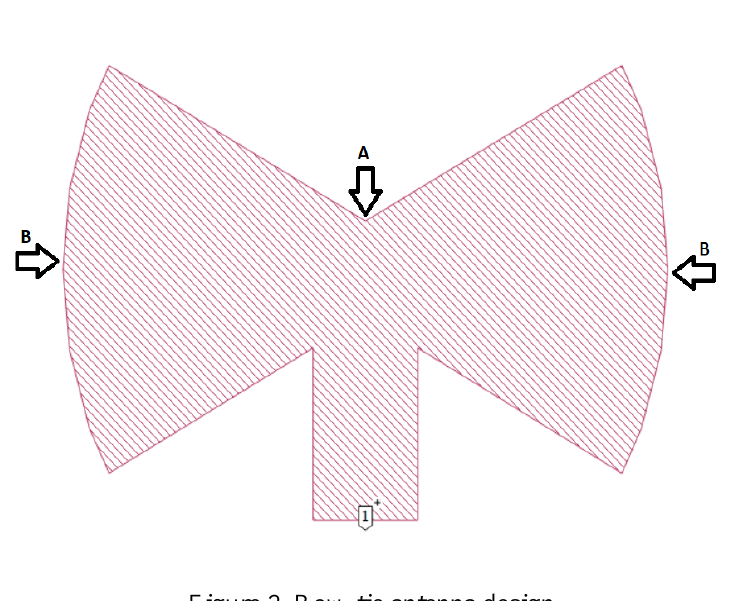
Figure 2. Bow-tie antenna